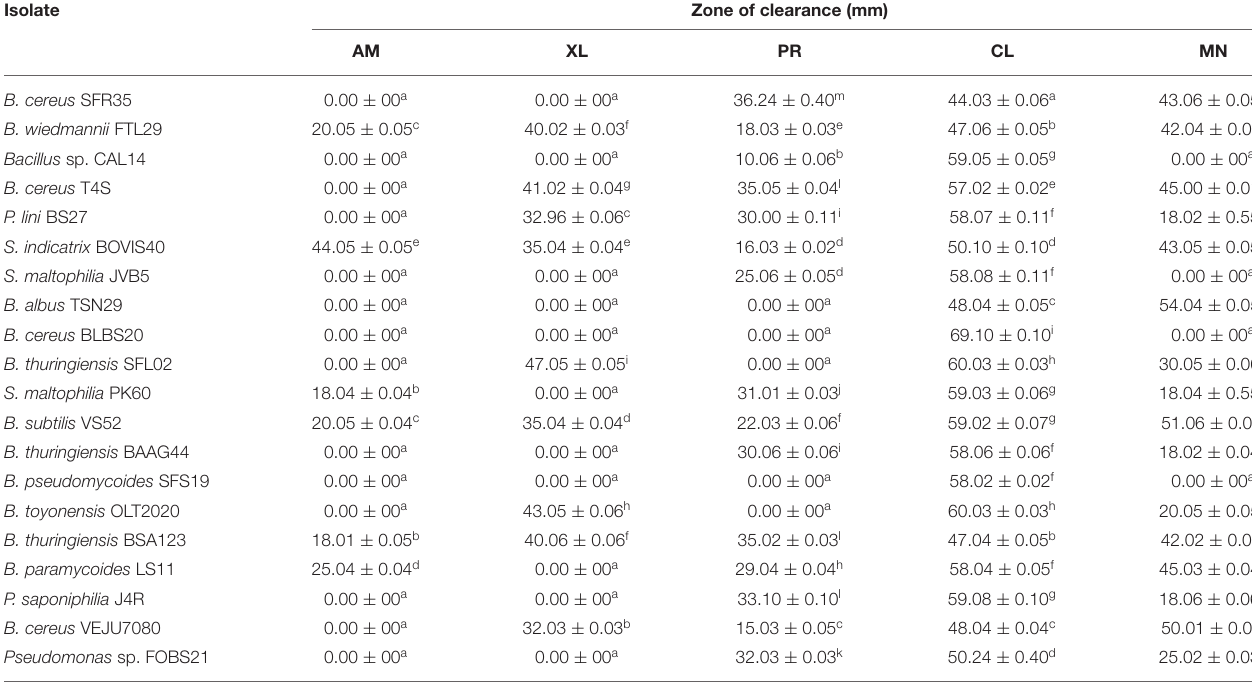
TABLE 4 | Qualitative screening of endophytic bacteria for enzyme production.